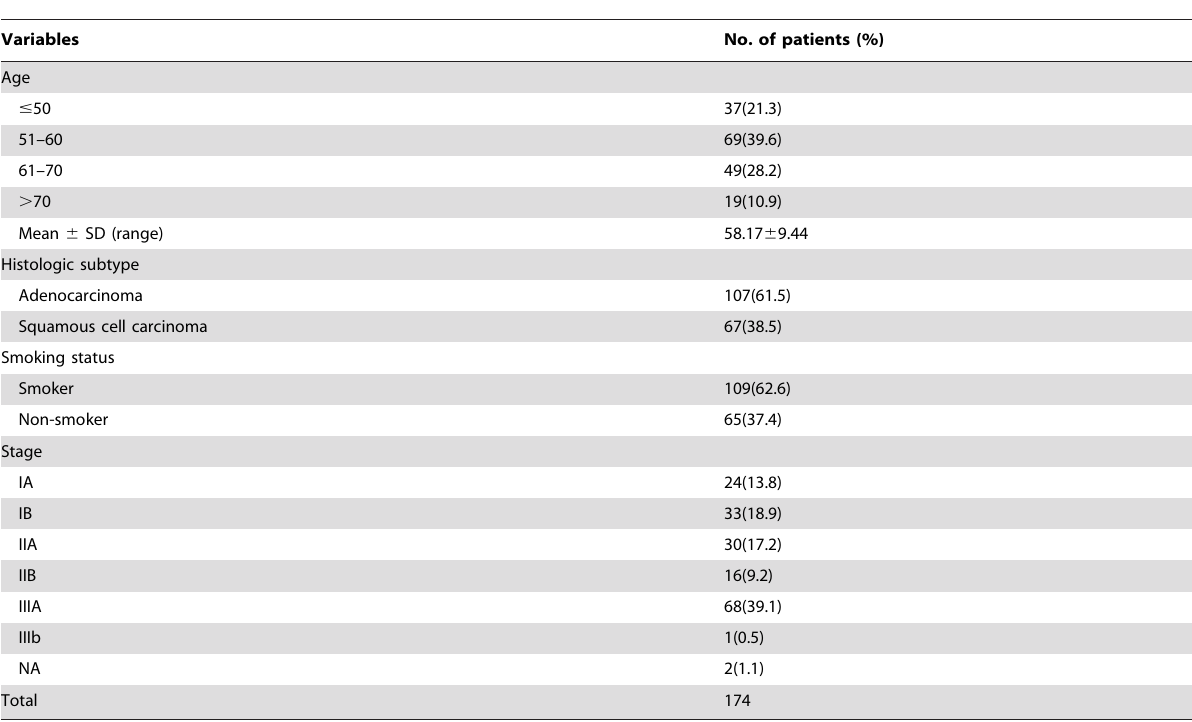
Table 1. Demographics and clinicopathologic features of 174 patients with NSCLC.